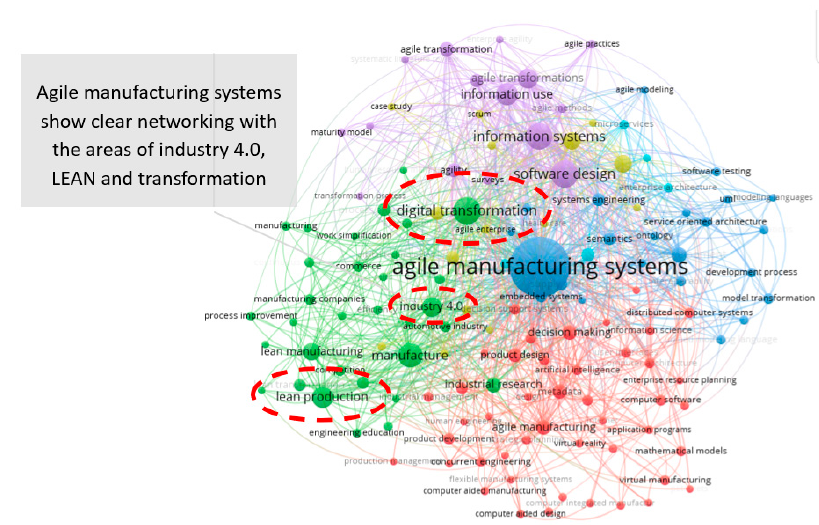
Figure 6. VOSviewer: Result—agile manufacturing transformation.